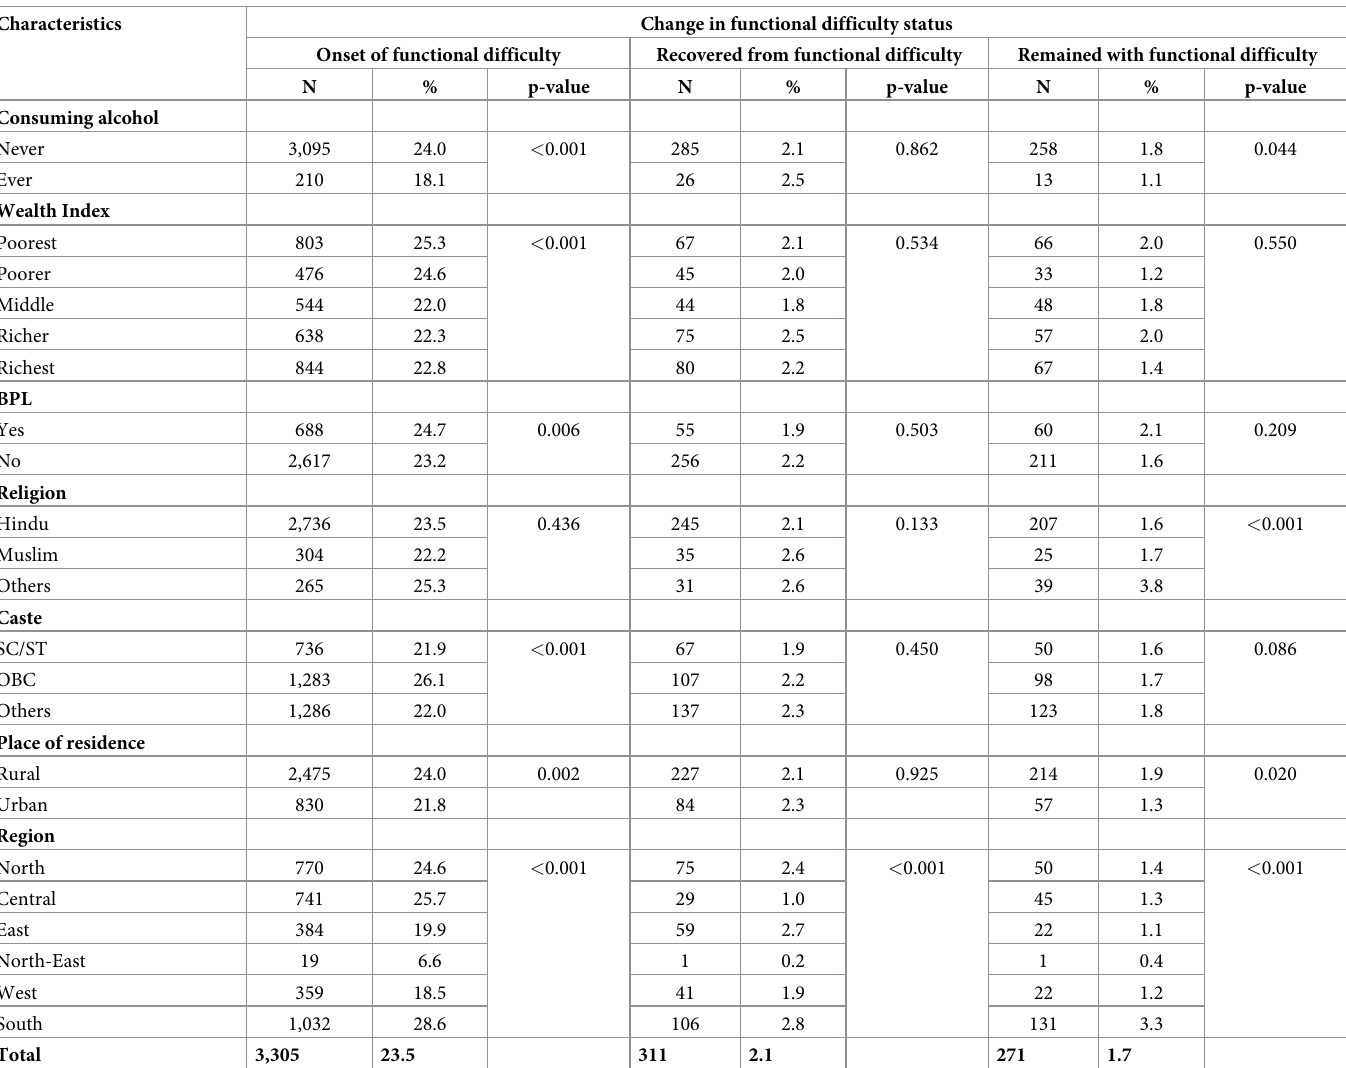
“onset of difficulty in second round”, “recovery from difficulty in second round” and “diffi- culty in both the rounds”. The onset of difficulty, difficulty recovery and difficulty remaining increased with increasing age. The onset of difficulty in the second round (27.3% vs 19.7%), difficulty recovery in the second round (2.3% vs 2.0%) and difficulty remaining in second round (2.2% vs 1.2%) were higher among females as compared to males. In case of geographi- cal regions, southern region (28.6%) showed higher functional difficulty and north-east region (6.6%) had lower level of onset of functional difficulty in the second round. Table 3 reveals the correlates of onset, recovery and remaining with functional difficulty among older adults. Older participants with single morbidity were 1.9 times more likely to have onset of difficulty, 2 times more likely to have difficulty recovered and 2.5 times